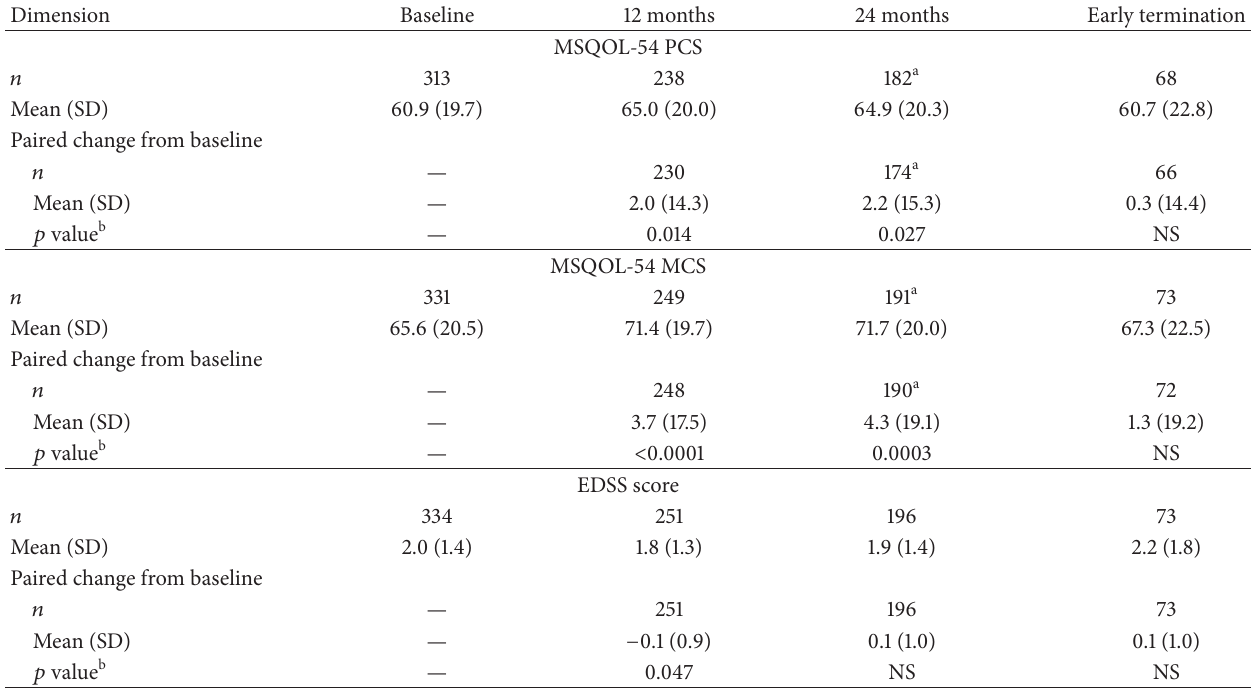
Table 2: Mean values and paired changes from baseline in MSQOL-54 PCS and MCS and in EDSS